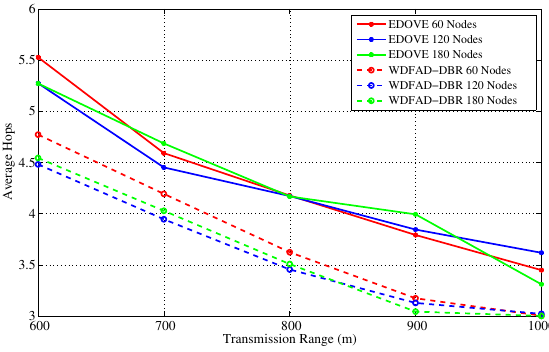
Figure 22. Average No. of Hops data messages traversed versus the transmission range.